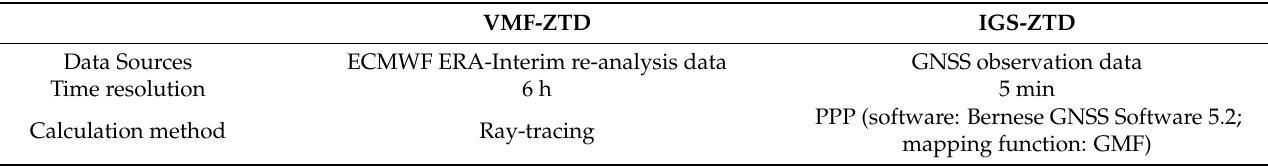
Table 3. Information about Vienna Mapping Functions (VMF)-ZTD and International Global Navigation Satellite Systems (GNSS) Service (IGS)-ZTD